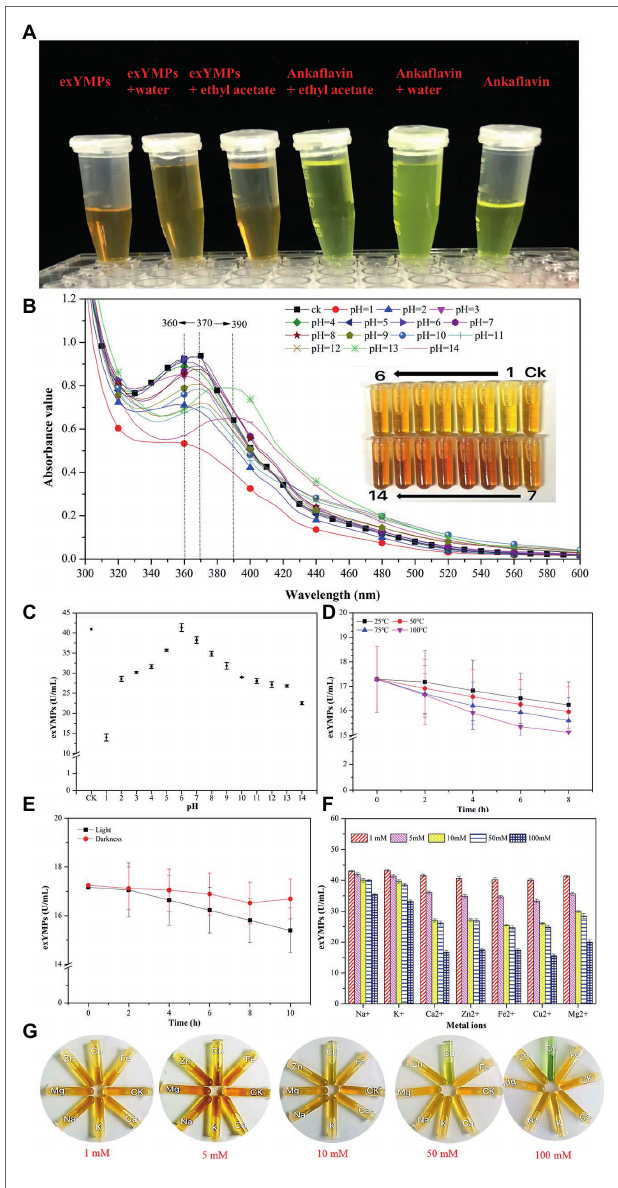
FIGURE 5 | The polar analysis of extracellular yellow monascus pigments produced by the mutant strain M. purpureus H14 (A) ; spectral scan results (B) and the value (C) of extracellular yellow monascus pigments in a pH range of 1–14; the value stability of extracellular yellow monascus pigments produced by the mutant strain M. purpureus H14 subject to heat (D) , light (E) , metal ions (F) ; the tone of extracellular yellow monascus pigments in response to various metal ions with different concentrations (G)